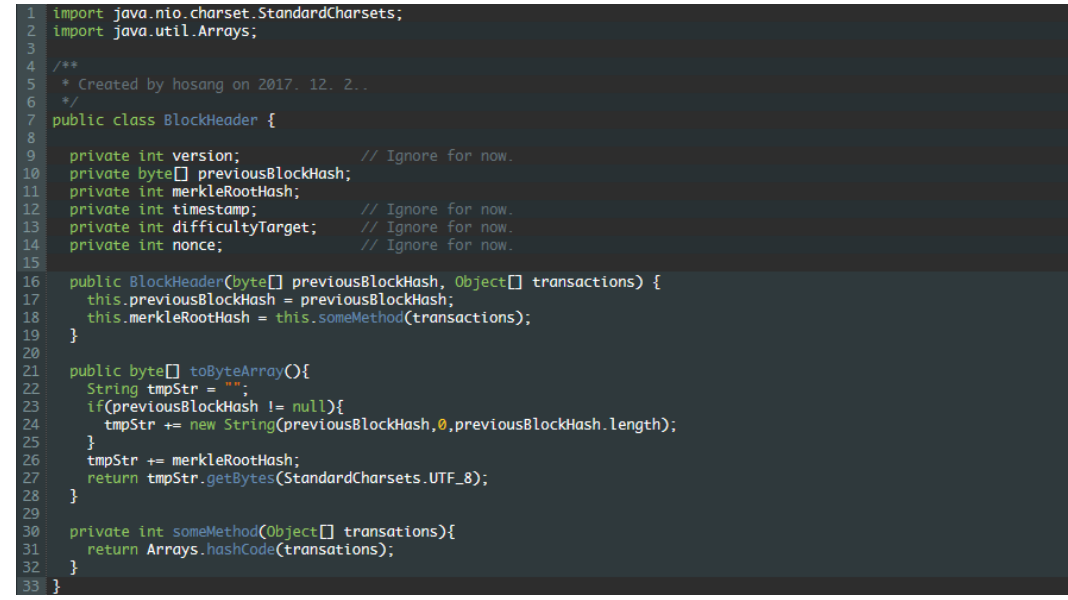
Figure 12. Constructor of the block header.